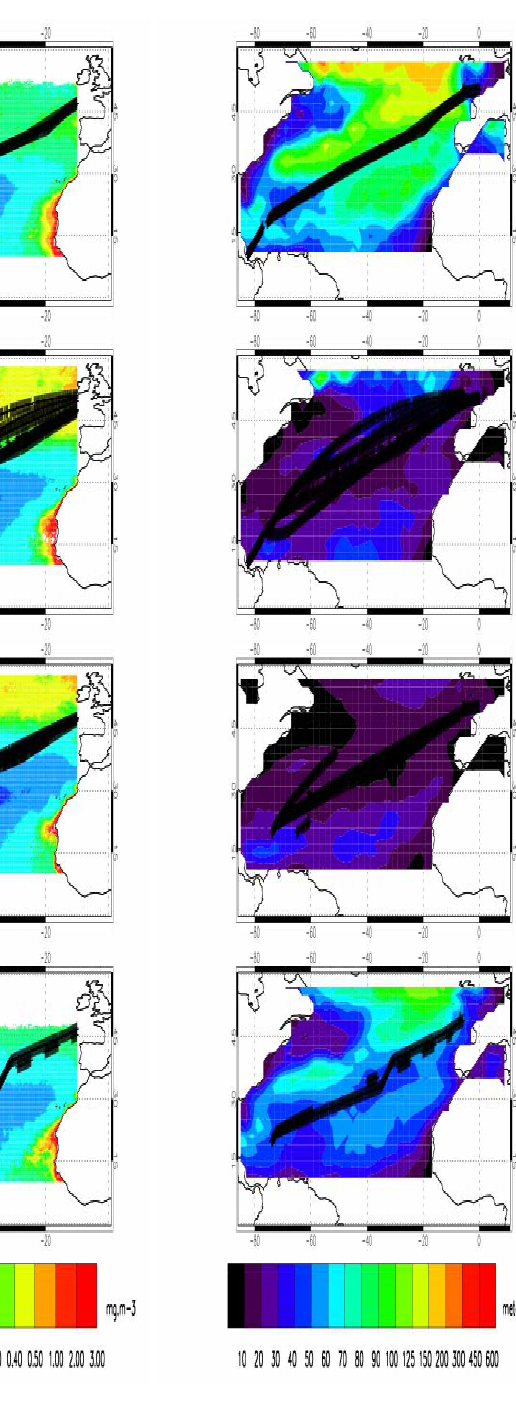
Fig. 1. Seasonal variations of the SST (left column), CHL (middle column) and MLD (right column) from winter (top row) to fall (bottom row). The tracks of in-situ pCO 2 measurements are shown on the figures in black